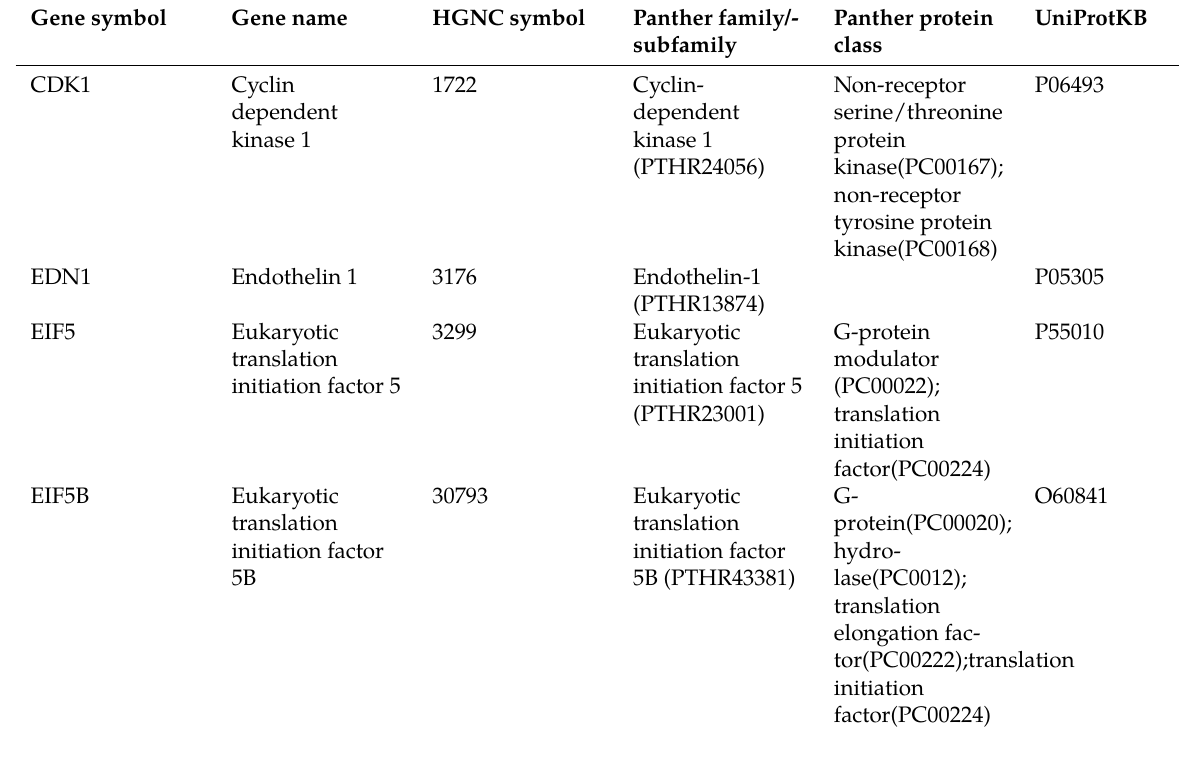
Table 4: Gene description of the common genes found in all three